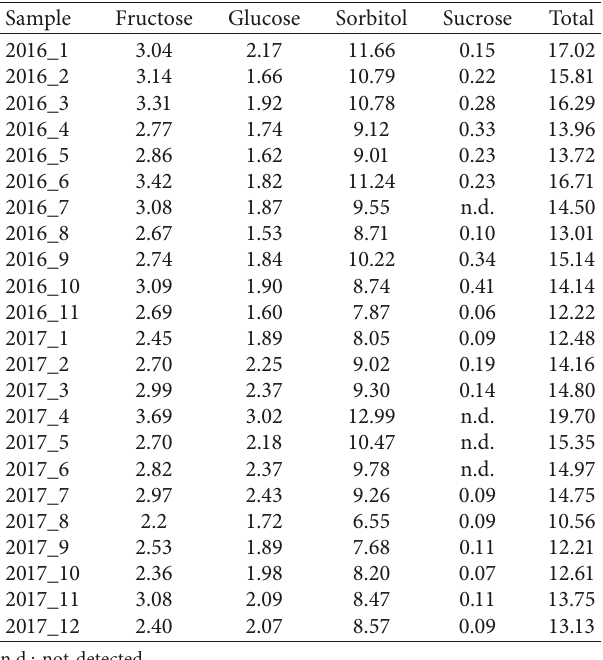
Table 1: Sugar content (g/100g FW) and composition of 23 samples of aronia berries.